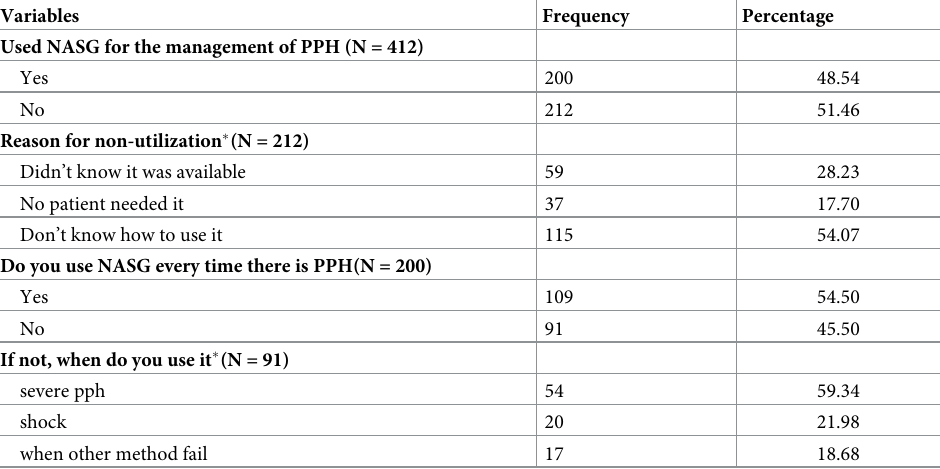
Table 5. Utilization of non-pneumatic anti-shock garment among obstetric care providers working in public health facilities of southern Ethiopia, 2020.